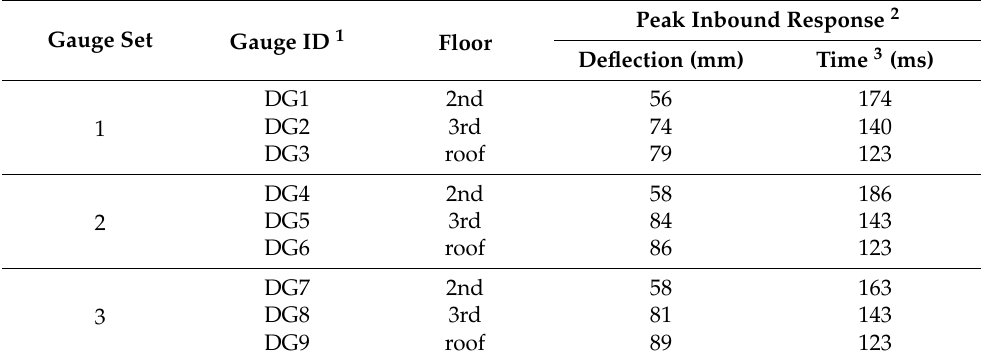
Table 4. Test 2—Measured peak inbound lateral deflection of the frame.